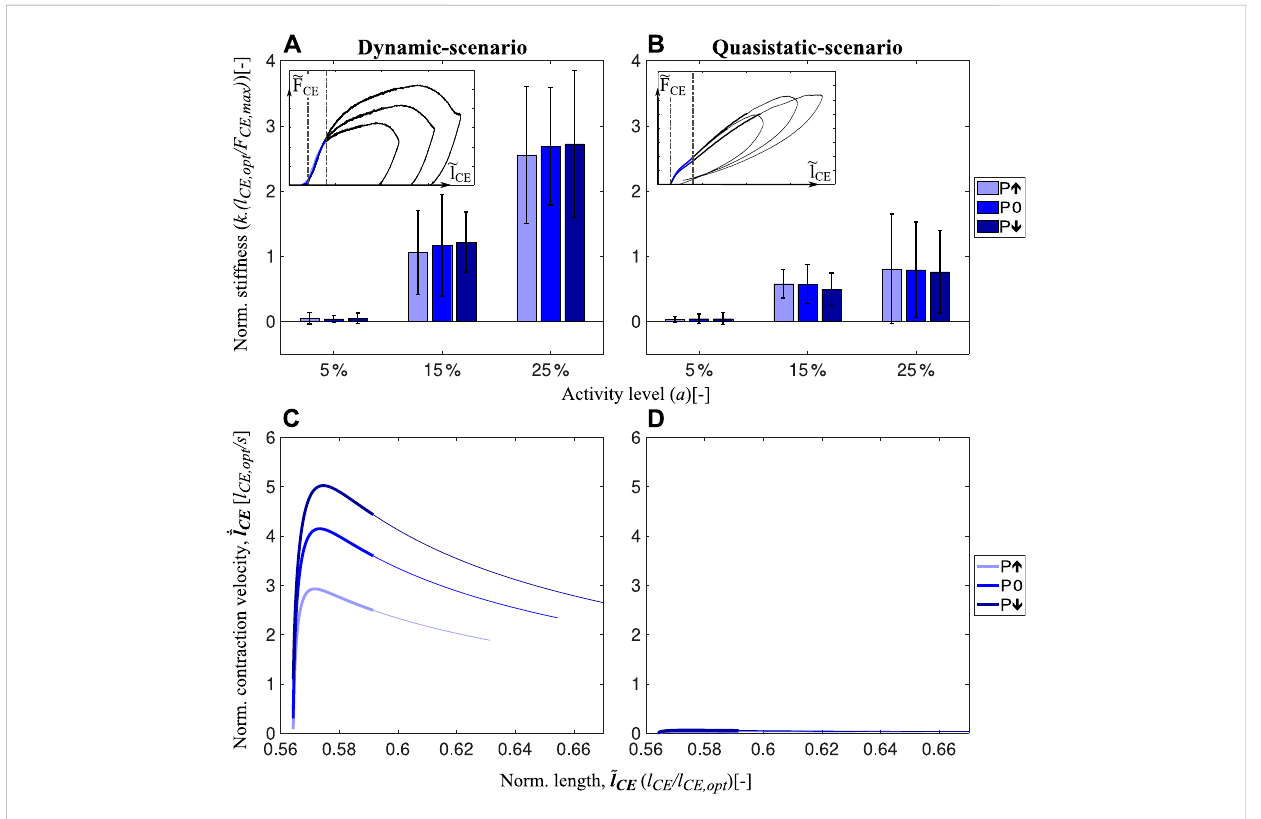
FIGURE 6 Short-range stiffness of muscle fi bers during the dynamic-scenario (A) . Stiffness amount during the short-range stiffness lengthening during quasistatic-scenario experiments (B) for all perturbation and activity levels are shown in the bar charts. Boundary conditions for the stiffness calculations for both speed conditions are shown as insets. In addition, velocity-length pro fi les during the pre fl ex phase are presented in (C) and (D) for actual and quasistatic-scenario experiments, respectively. Thick lines show the short-range stiffness phase, and thin lines present the remaining part of the pre fl ex